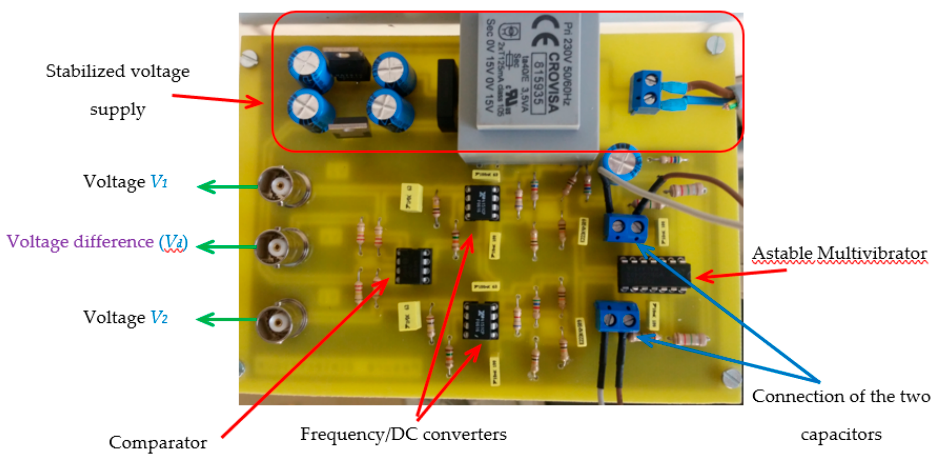
Figure 6. Electronic card made for measurements.